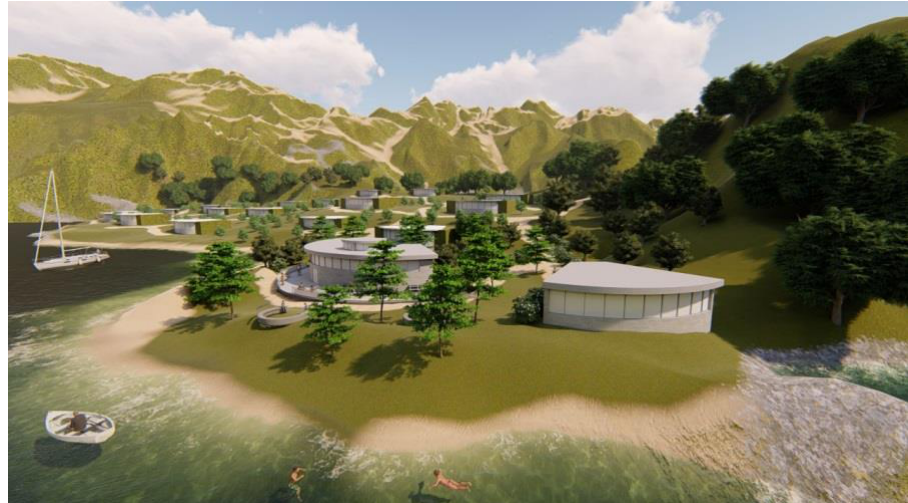
Figure 40. Visitor Centre and tourist residential units of the Tourist Resort Lepenski Vir, in the background. Lepenski Vir, Serbia (2019) by ArhiArhi (Predrag, Vladimir and Grigor Milošević)